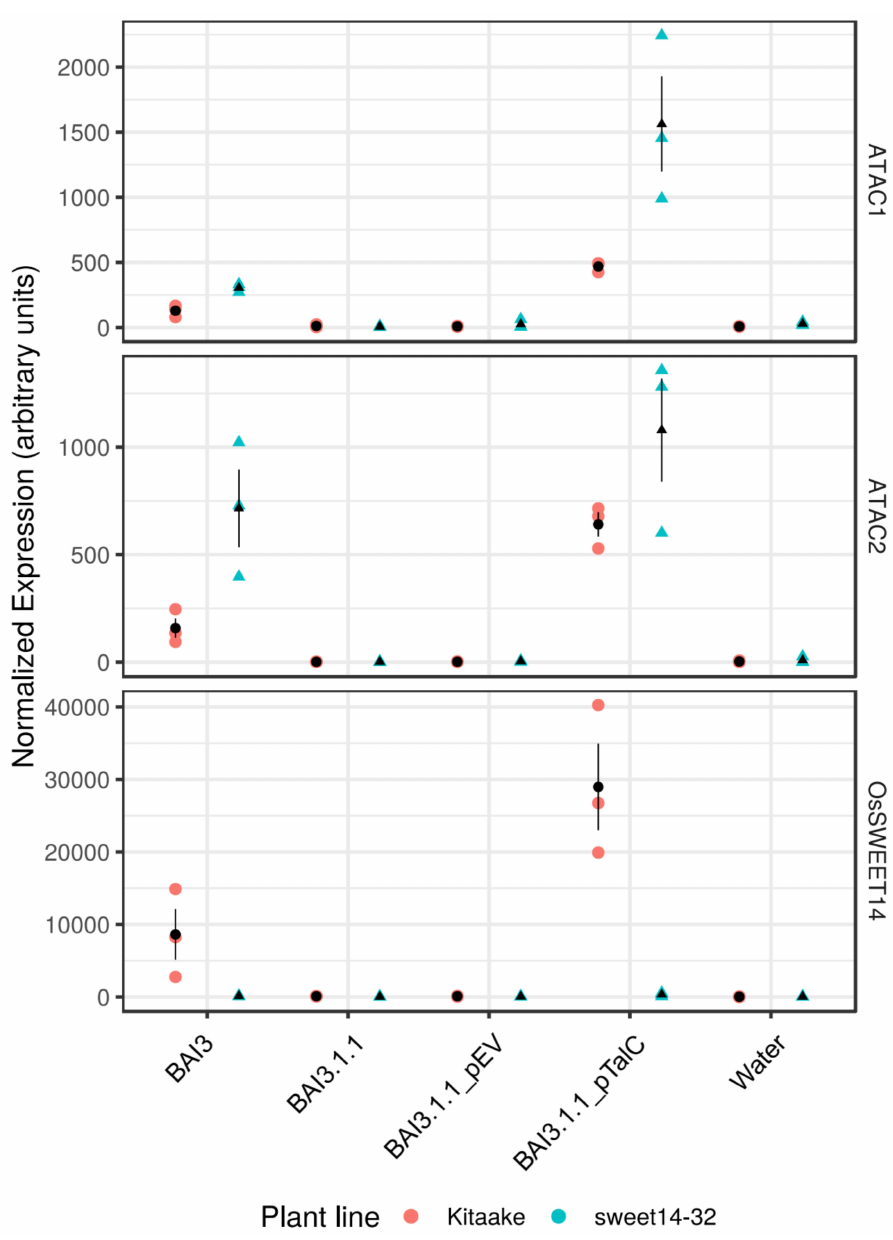
Figure 2. ATAC transcript induction in response to BAI3 is talC dependent. Transcript expression of ATAC1, ATAC2, and SWEET14 on the wild-type Kitaake and the edited sweet14–32 lines measured 48 h after inoculation with derivatives of the BAI3 strain or water. The strains are represented on the x -axis: BAI3.1.1 is a BAI3 derivative defective for talC . “_TalC” or “_EV” suffixes indicate, respectively, that the talC strain carried a plasmid expressing TalC or the corresponding empty vector. Expression levels of the different transcripts measured by qRT-PCR are expressed in arbitrary units and calculated by the ∆ Ct method. Individual biological replicate values ( n = 3) are denoted with colored symbols as a function of the inoculated plant line. The black dots and line ranges denote the mean and the standard error,